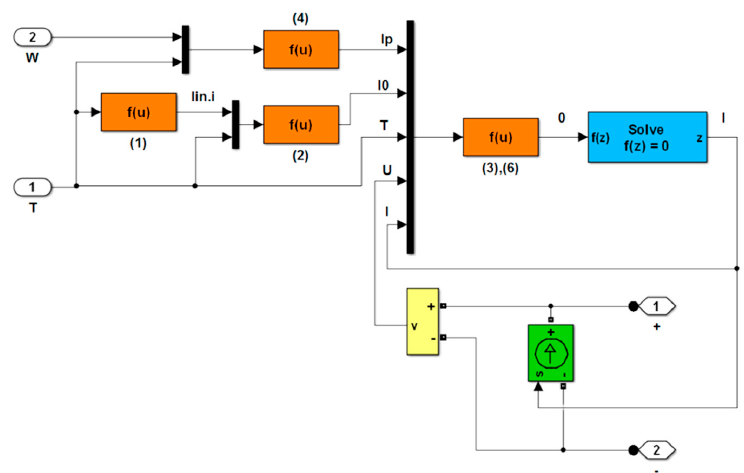
Figure A1. Scheme for solving the system of Equations (1)–(6) describing the operation of the photocell.